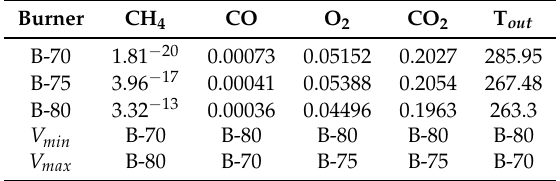
Table 3. Comparison of the most critical parameters for the selection of the optimum combustion chamber. Burner CH 4 CO O 2 CO